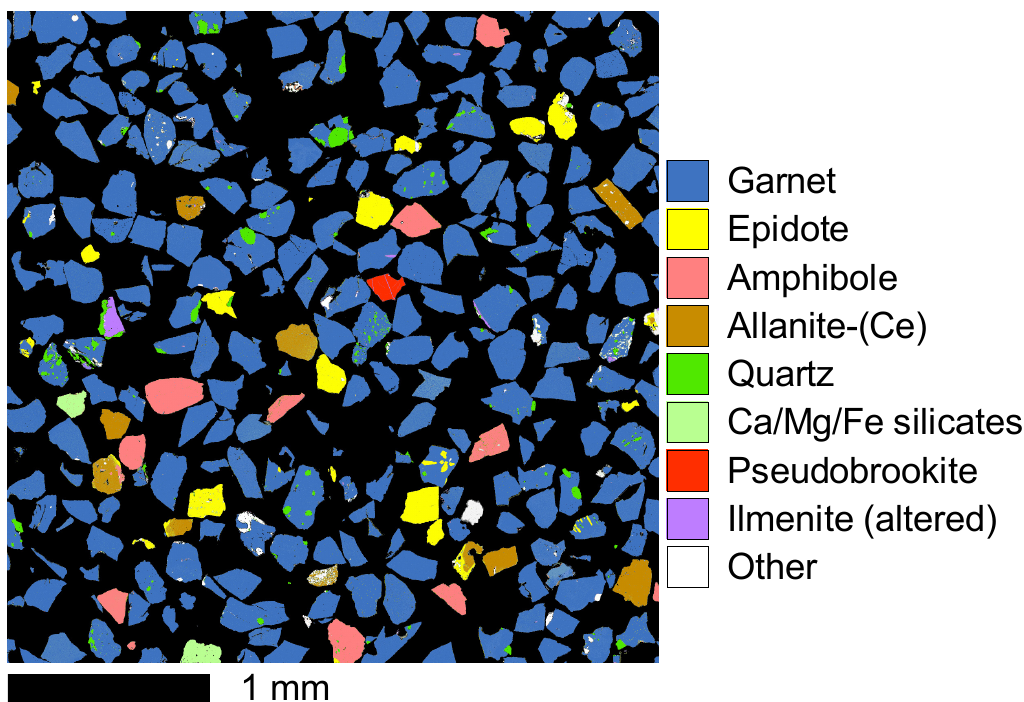
Figure 9. EPMA map results for the garnet concentrate showing the phase patched map with the distribution of all phases present in the sample. Only phases with an abundance of >1% by area are shown. Trace phases are labelled as ‘Other’. Operating conditions for the microprobe during mapping were an accelerating voltage of 20 keV, a beam current of 80 nA, a step size of 2 µm (in x and y) and a counting time of 15 ms per step.